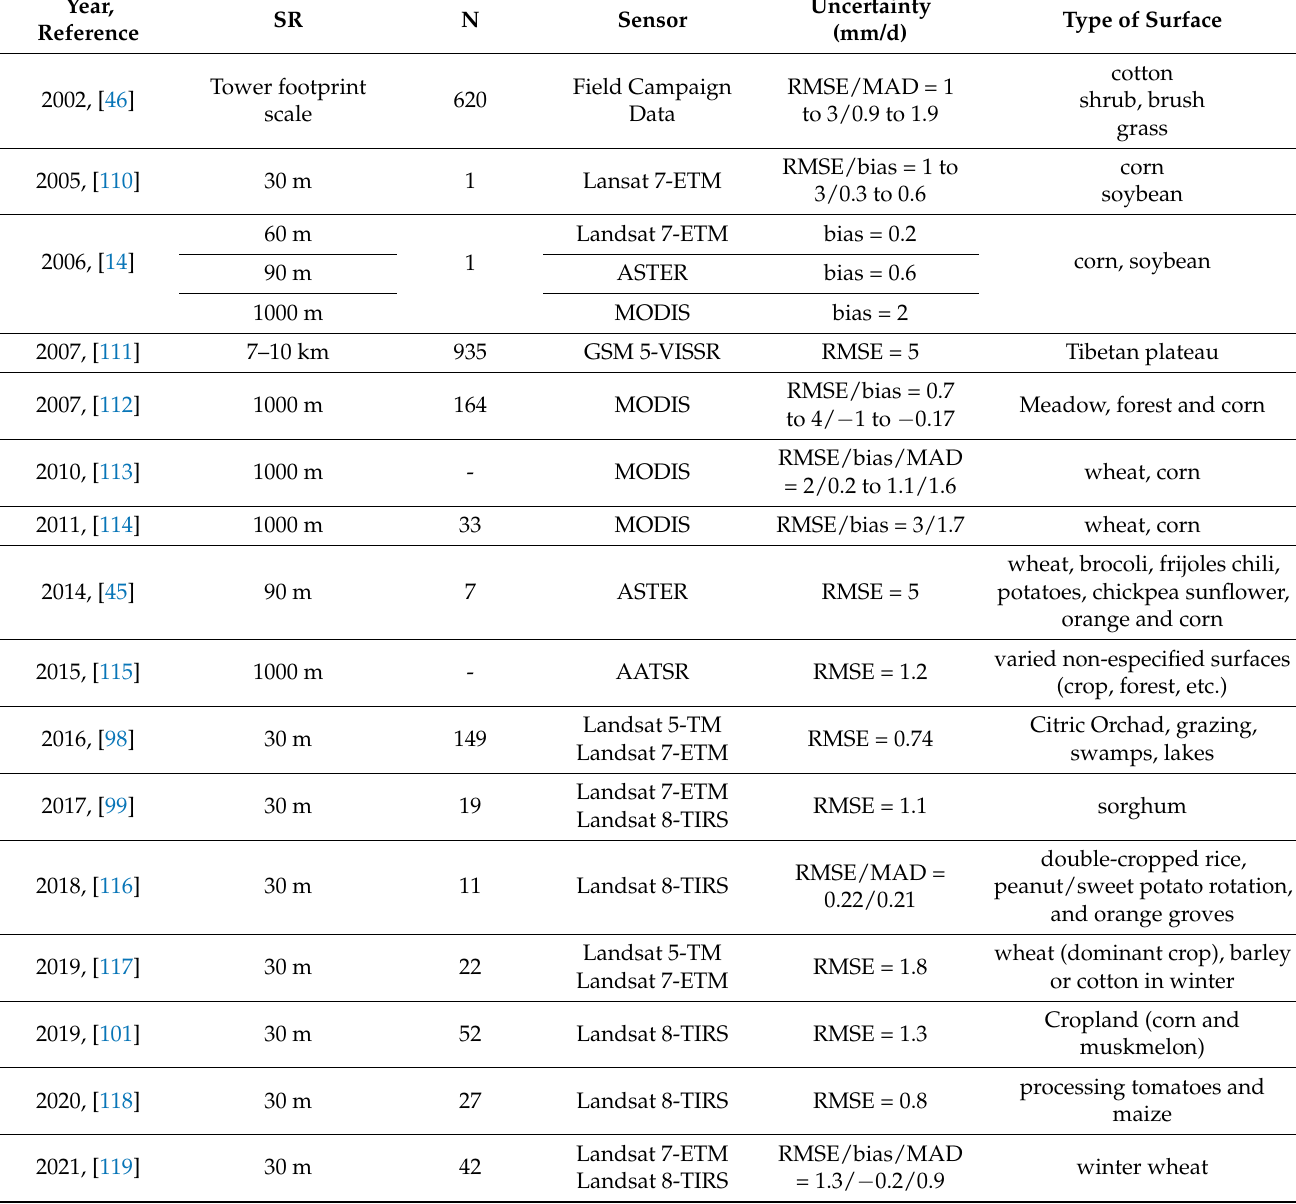
Table 2. Representative chronological compendium of validation studies of the SEBS algorithm. Reference, spatial resolution (SR), number (N) of satellite scenes, Sensor Name, Uncertainty and Type of Surface are detailed (uncertainty statistics are averaged values of all type of surface studied). Statistical uncertainties are Root Mean Square Error (RMSE), bias, and Mean Absolute Difference (MAD), are shown for ET d (mm/d). Different uncertainty rows inside the cell means uncertainty associated to the satellite